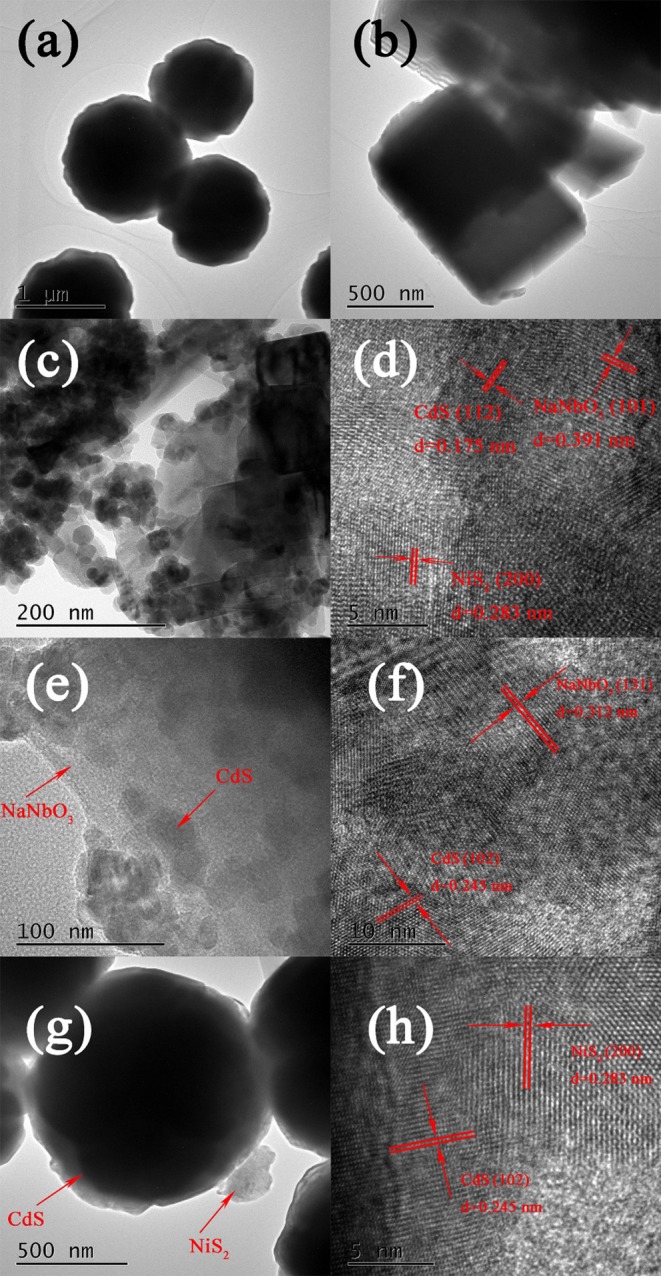
TEM and HRTEM images of (a) CdS, (b) NaNbO3, (c,d) NCN40%, (e,f) NC40%, and (g,h) CdS/NiS2.